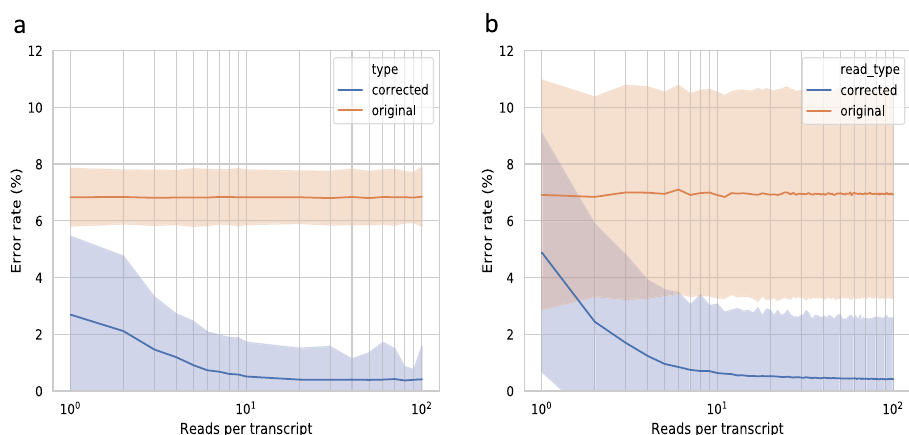
Fig. 2 Effect of read depth on error rate. a shows the median error rate of the SIM-ca read experiment based on true read depth of the transcript (i.e. number of reads sequenced from it). b shows the median error rate of the SIRV data as a function of read depth, obtained via subsampling (see “ Data analysis ” ). The shaded areas show the standard deviation (SD) of the error rates.